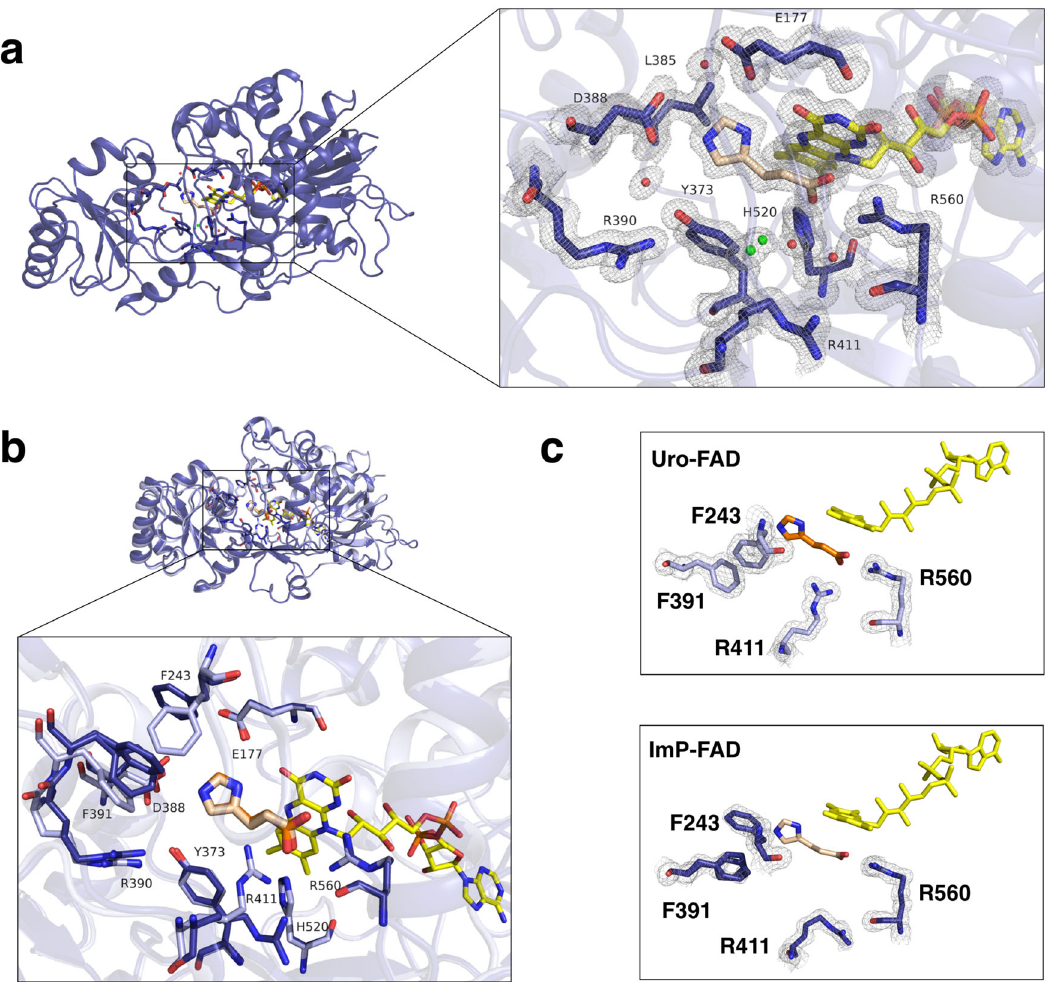
Fig. 4 X-ray structure of UrdA ′ in complex with imidazole propionate and FAD. a Active site in the imp-FAD structure, ImP (wheat), FAD (yellow), active site residues (blue sticks), water molecules (red spheres), and 2mFo-DFc map contoured at 1 σ and carved at 1.5 Å are shown. b Comparison between uro- FAD (light blue) and imp-FAD (blue) active site. The two structures were superimposed on the FAD domain. Urocanate (orange) and imidazole propionate (wheat) are shown. c Different conformations of Phe243, Phe391, and Arg411 in substrate/product-bound states. 2mFo-DFc map contoured at 1 σ is shown for these